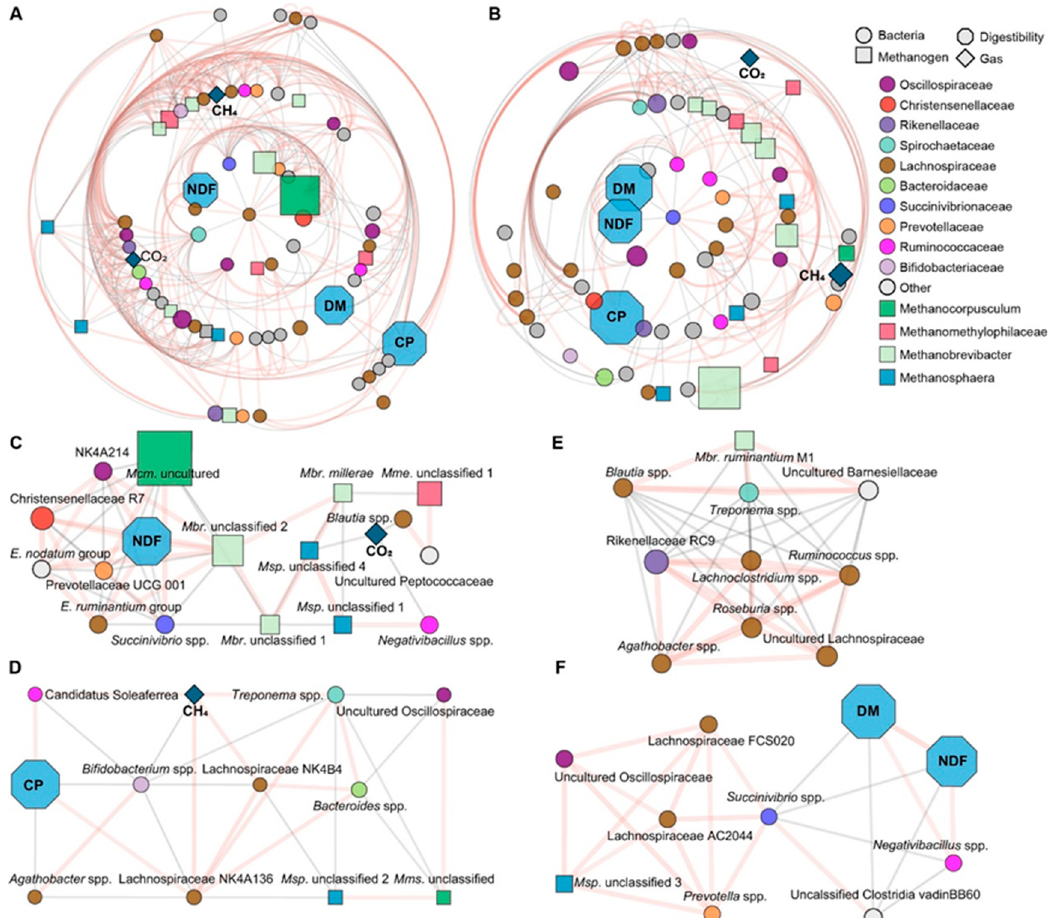
Figure 6. Differences in co-occurrence association networks between roe deer and goats. The association network of bacteria (genus), methanogens (species), digestibility, and gas yields between roe deer ( A ) and goats ( B ). The association network was calculated with the r.g function and was visualized in Cytoscape with the Radial layout algorithm layout. The densely connected networks in roe deer ( C , D ) and goats ( E , F ). The networks were identified by MCODE. The ellipse, rectangle, octagon, and diamond shapes represent bacteria, methanogens, digestibility, and gas yields, respectively. The shape size means the average relative abundance of taxa or the average amount of digestibility and gas yields. The colored ellipse and rectangle indicate bacteria and methanogens, respectively. The gray and pink edge lines represent negative and positive correlations, respectively. Edge width indicates the correlation coefficient, with bold lines for a greater coefficient, and thick lines for a weaker coefficient.